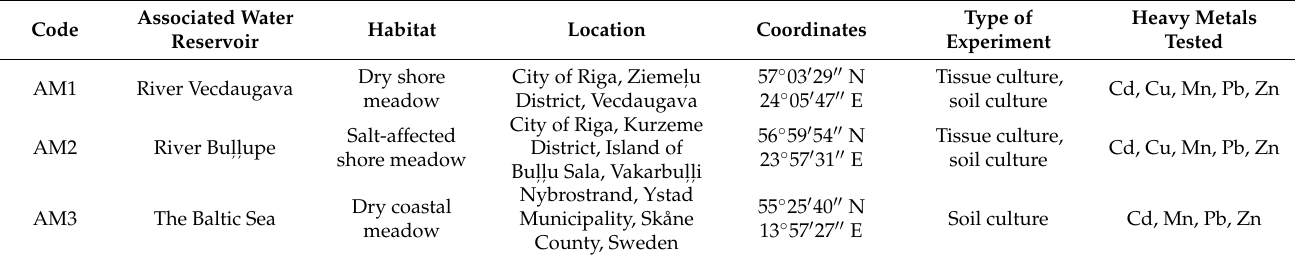
Table 1. Accessions of Armeria maritima used in the present study and performed